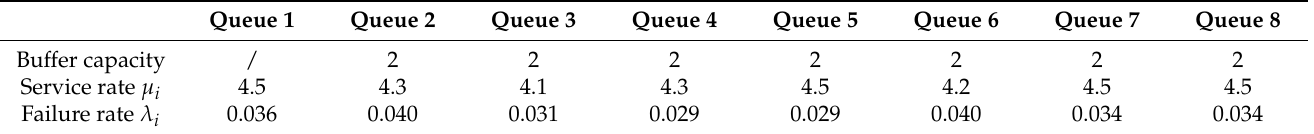
Table 1. Configuration information and reliability parameters.